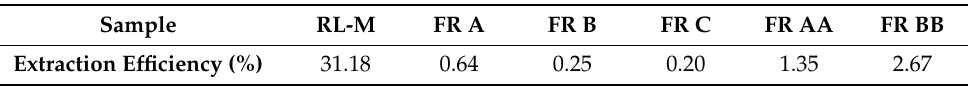
Table 5. Extraction efficiencies for RL polyphenolic samples (% w/w of dry plant weight). Abbrevia- tions as in Table